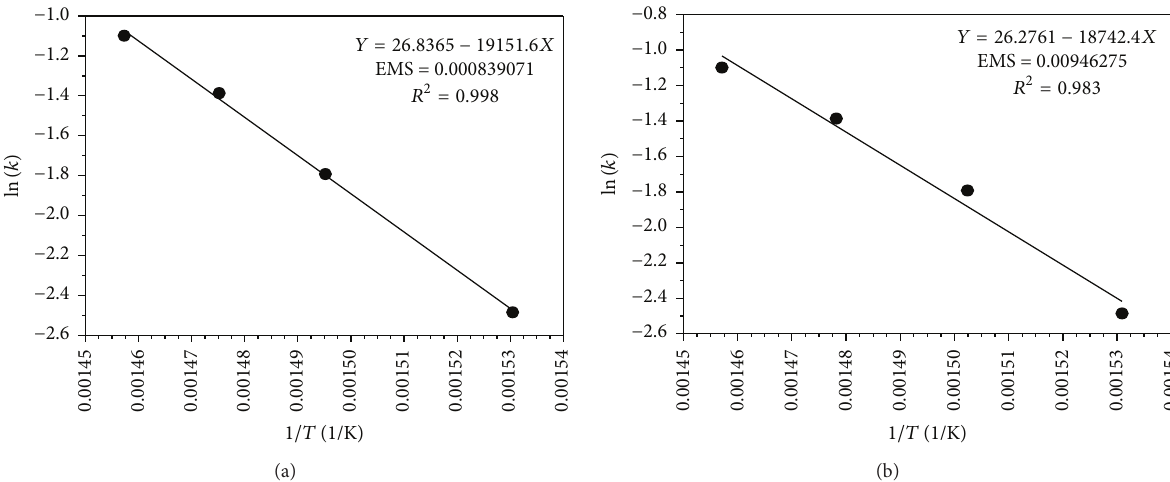
Figure 15: Arrhenius plots (a) neat epoxy and (b) 1-wt.% EG epoxy composite for mass fraction = 0.6 data obtained under nonisothermal conditions at heating rates 5, 10, 15, and 20Kmin −1 from Figures 14(a) and 14(b),